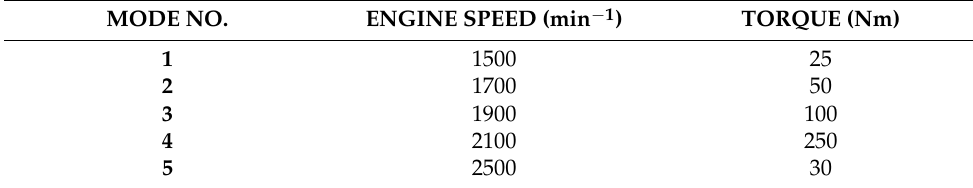
Table 3. Design of experiments comprising selected five steady-state operating modes. MODE